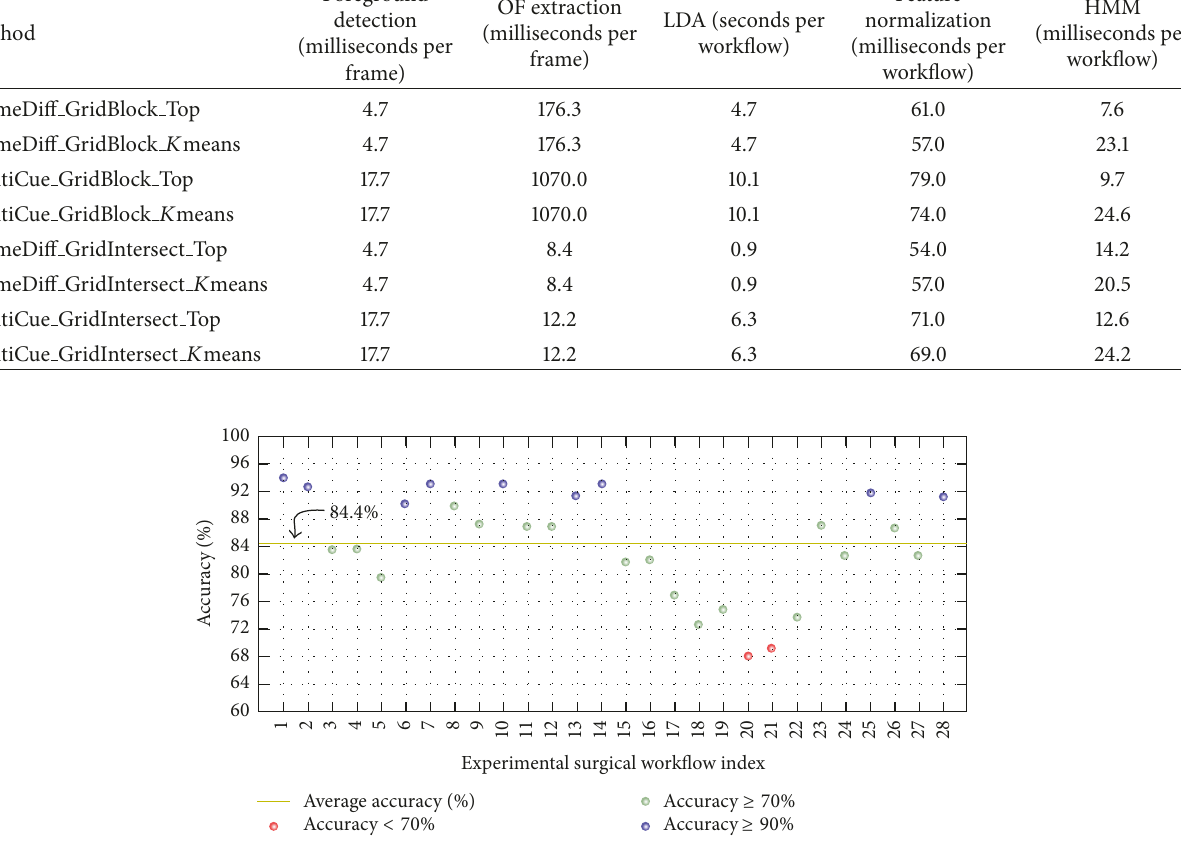
targets for each camera, and each camera can then track, focus on, and acquire motion information from only one